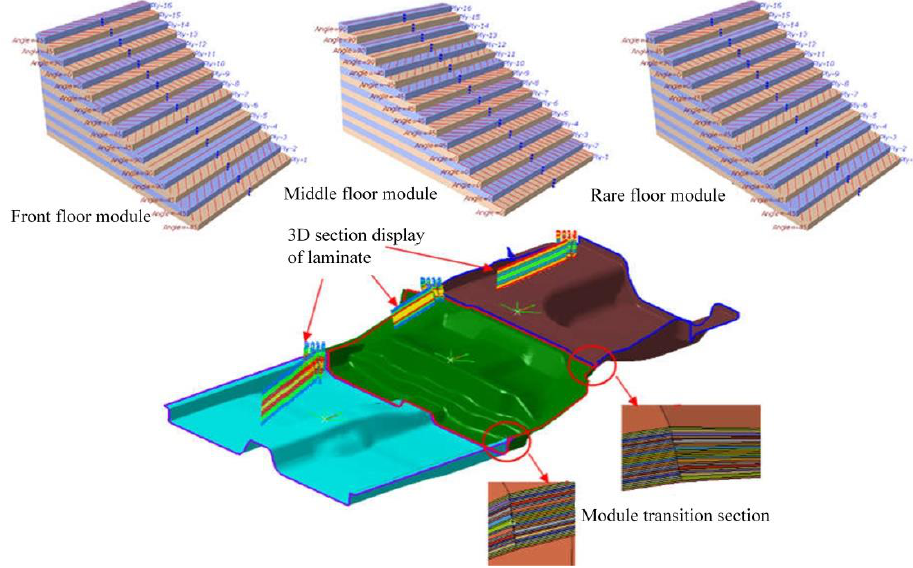
Figure 21. Layer design of CFRP floor.